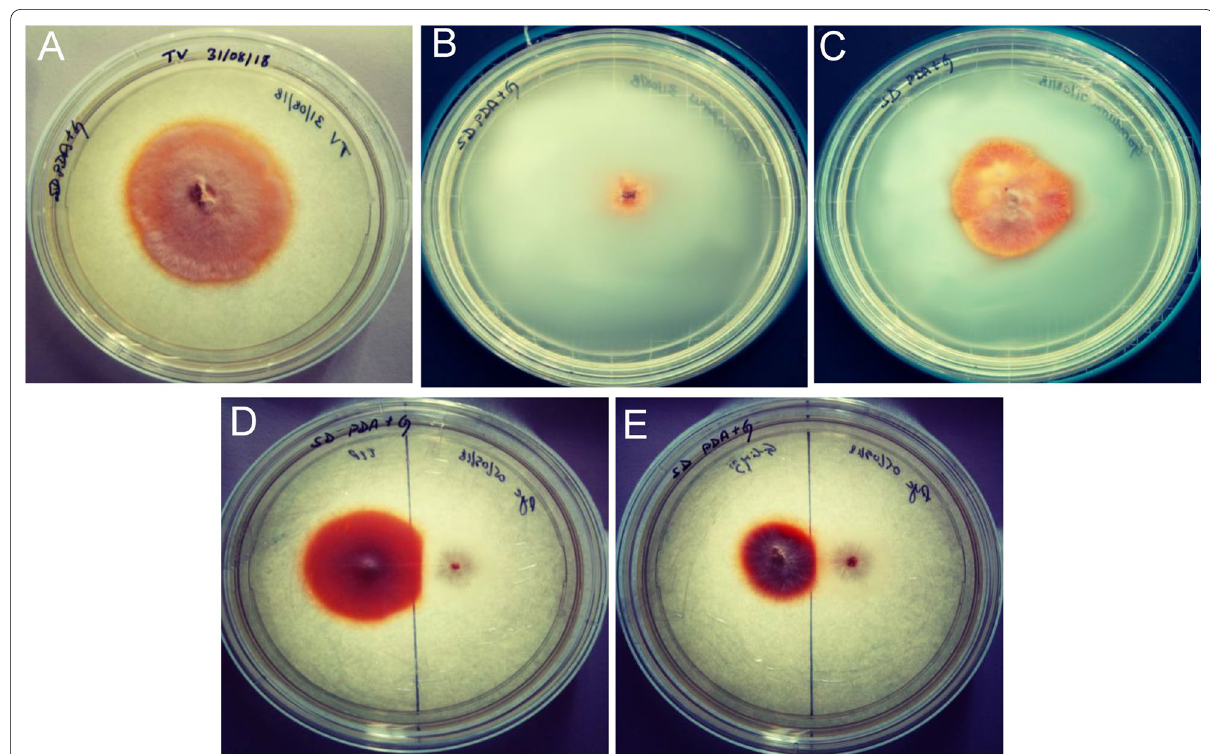
Fig. 5 Qualitative laccase activity for plate cultures. A T. versicolor (F1). B T. coccinea (F3). C L. lactinea (F9). D T. coccinea versus T. versicolor. E T. coccinea versus L.